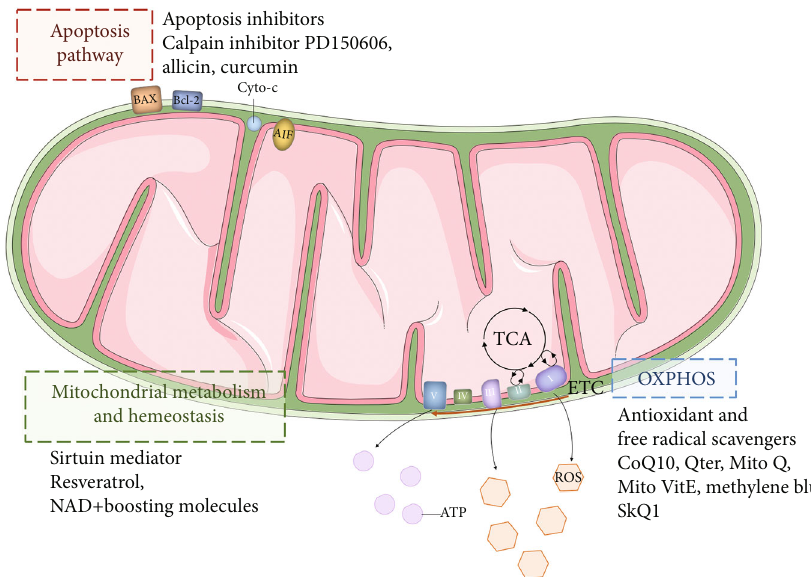
Figure 2: Pharmacological targets of mitochondria in auditory neuropathy. Pharmacological therapeutics of mitochondrial dysfunction to rescue auditory neuropathies are still limited. Proven therapeutic strategy targets are comprised of apoptosis inhibition, sirtuin mediators maintaining mitochondrial homeostasis and capability of metabolism, and antioxidants and free radical scavengers that are helpful to alleviate oxidative